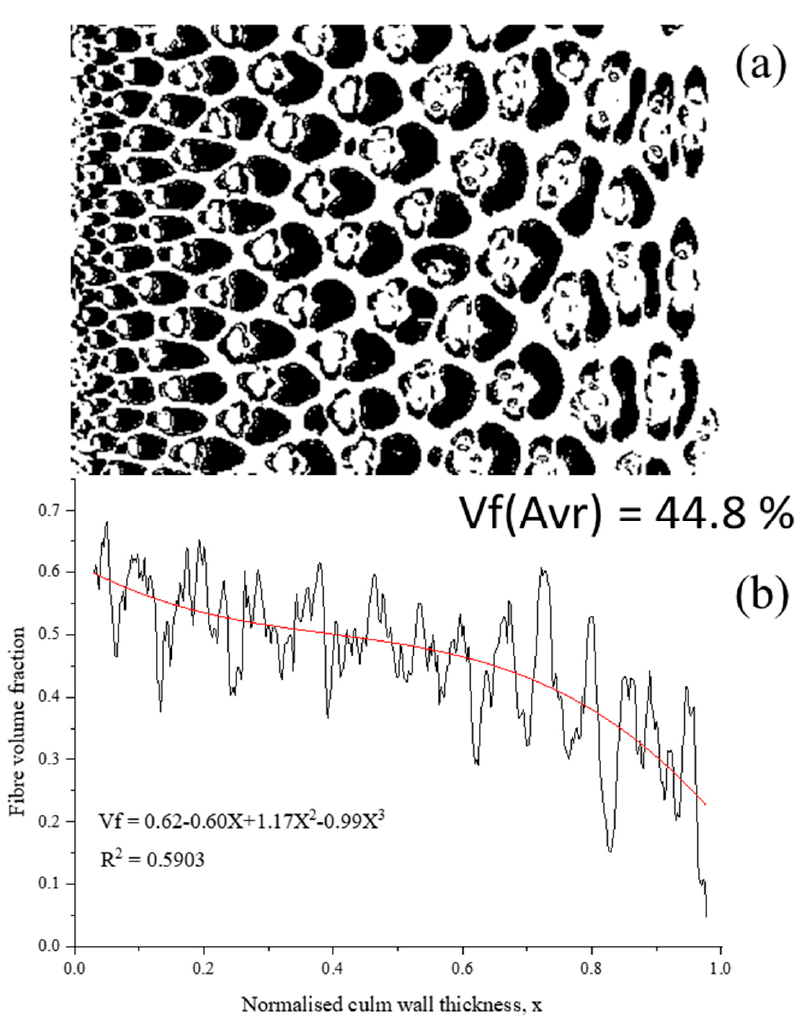
Figure 3. Fiber distribution in the composite bamboo ( D. Asper ). ( a ) example of digital image analysis; ( b ) fiber volume distribution across the culm wall.